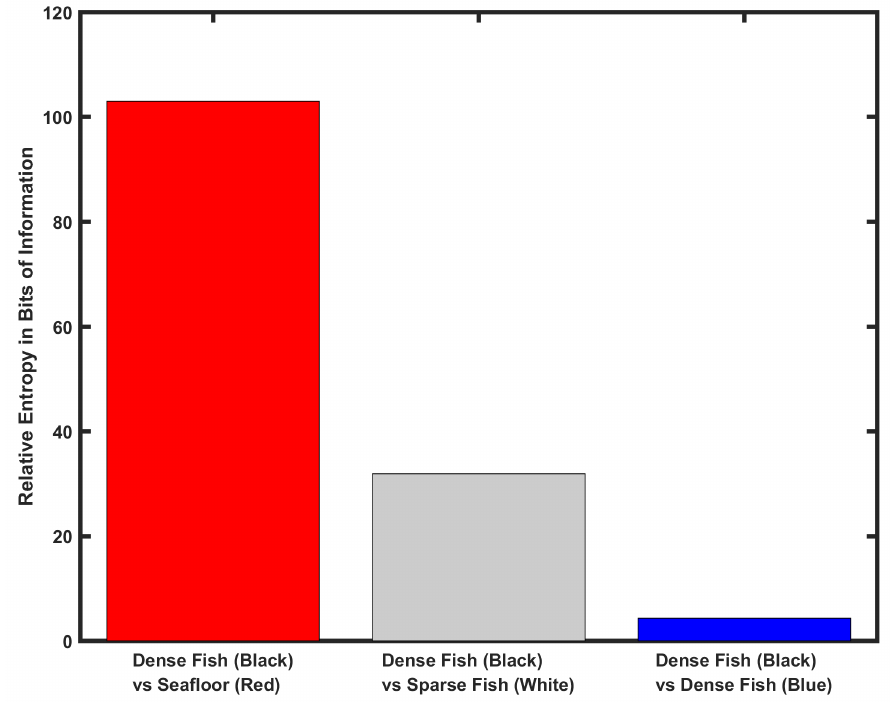
Figure A2. Kullback–Leibler divergence (in bits) from Equation (A1) comparing black-contoured densely populated fish region with red-contoured seafloor region, white-contoured sparsely popu- lated fish region, and blue-contoured densely populated fish region, imaged on 4 October at 00:16:15 EDT and shown in Figure